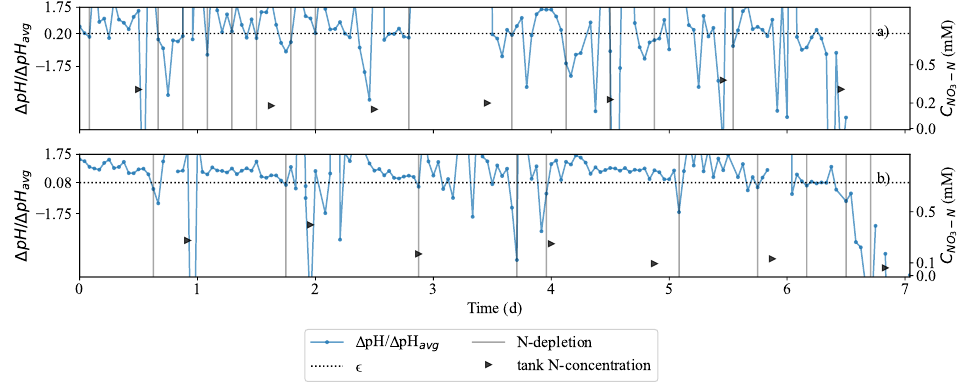
Figure 5. Comparative plot of experiment where the ratio between the absolute change in pH and the running average of absolute pH change ( ∆ pH/ ∆ pH avg ). The threshold for this ratio was set to a value referred to as the depletion threshold ( (cid:101) ): 20% ( a ) and 8% ( b ). In ( a ) and ( b ) ∆ pH/ ∆ pH avg was plotted for each case. When ∆ pH/ ∆ pH avg dropped below (cid:101) , this was the point where the system indicated nitrogen depletion below detectable concentration for the plant. The nitrate-nitrogen concentrations were observed to be decreasing over time until minimum nitrate level was reached, 0.22 mM in ( a ) and 0.061 mM in ( b ) medium nitrate concentration despite regular feeding of fresh medium dosed at the times indicated on the